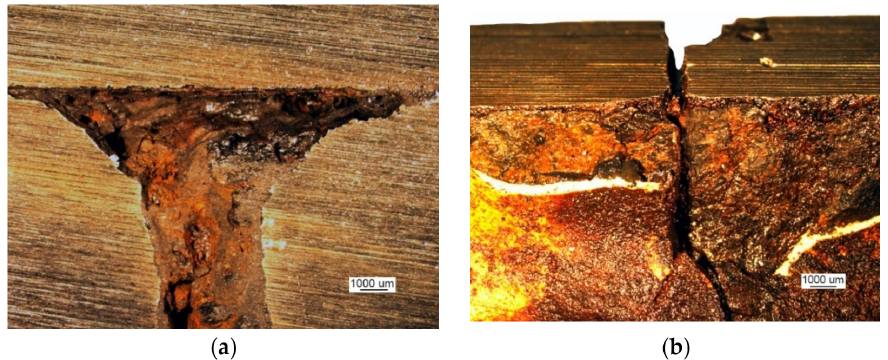
Figure 43. Stereoscopic optical microscopy views (handy-size bulk carrier 30185 DWT): ( a ) crack reaches part 2 and ( b ) crack transition from part 1 (upper part of the figure) to the